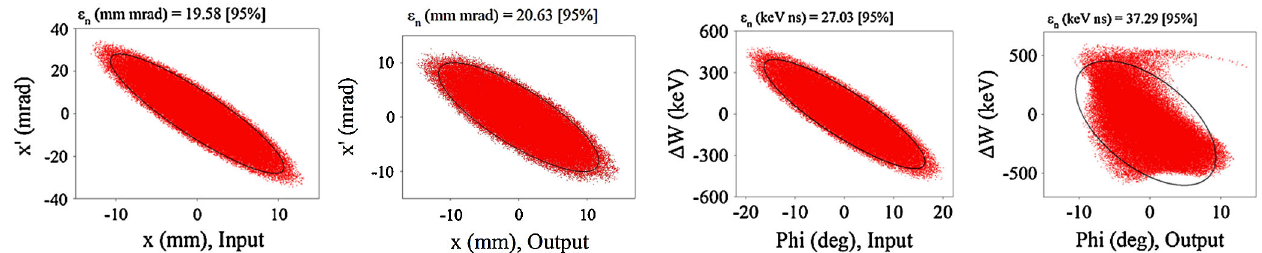
FIG. 24. Transverse (left) and longitudinal (right) particle distribution at entrance and exit of the CH-DTL section at 500 mA equivalent beam current. The input and output energies of the CH-DTL were 10 and 40 MeV, respectively. Normalized emittance values are relevant for the plotted 95% ellipses.